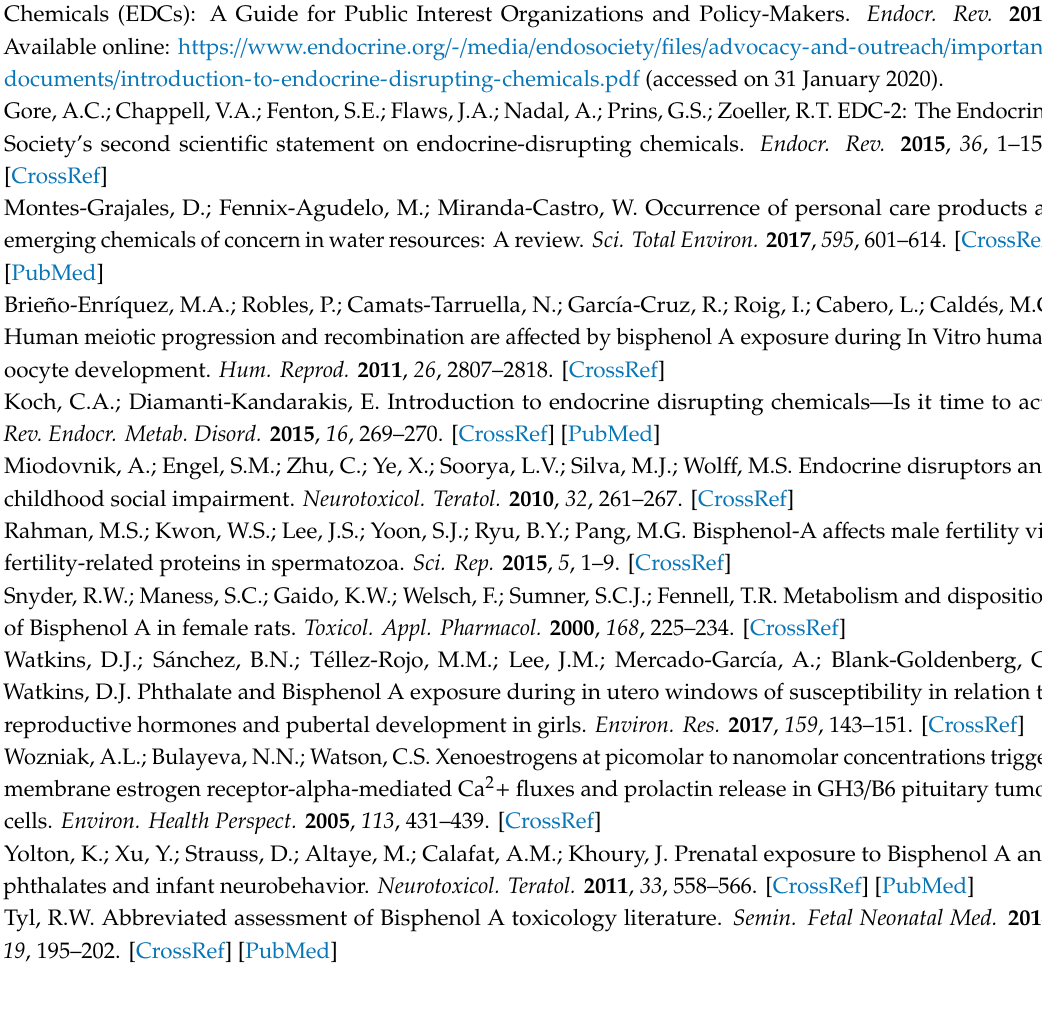
Table S1: Interactions of genes involved in metabolism in 3 nM BPA-treated non-ST-BeWos, Table S2: Interactions of genes involved in metabolism in 10 nM BPA-treated non-ST-BeWos, Table S3: Interactions of genes involved in metabolism in 3 nM BPA-treated ST-BeWos, Table S4: Acronyms of genes involved in regulation of nucleic acid metabolism, metabolism and energy pathways, Table S5: Interactions of genes involved in metabolism in 10 nM BPA treated